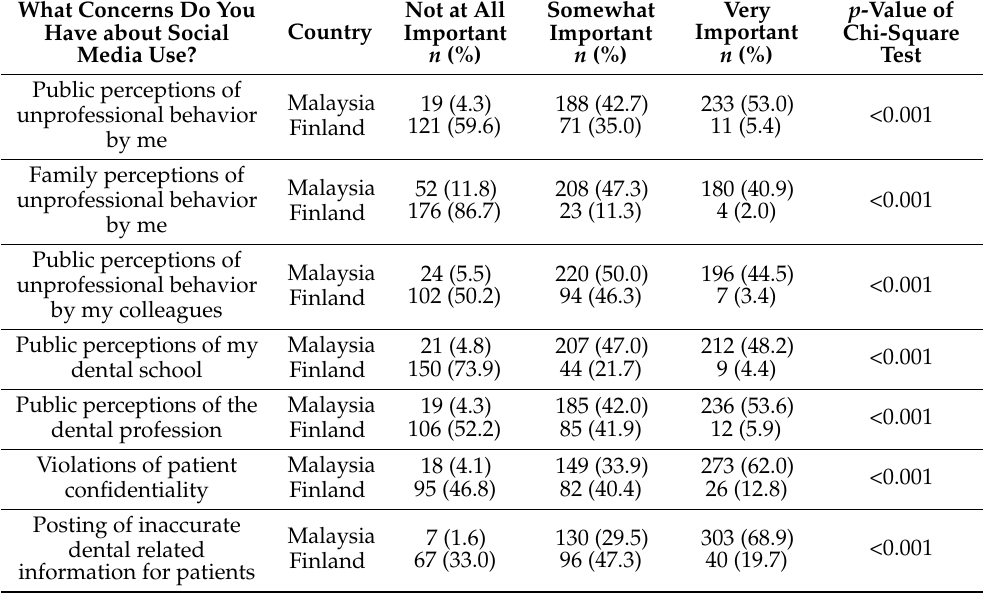
Table 1. The frequency and percentage distributions of basic characteristics among study partici ‐ pants from Malaysia ( n = 440) and Finland ( n = 203). Statistical significances between countries were evaluated by chi ‐ square test.